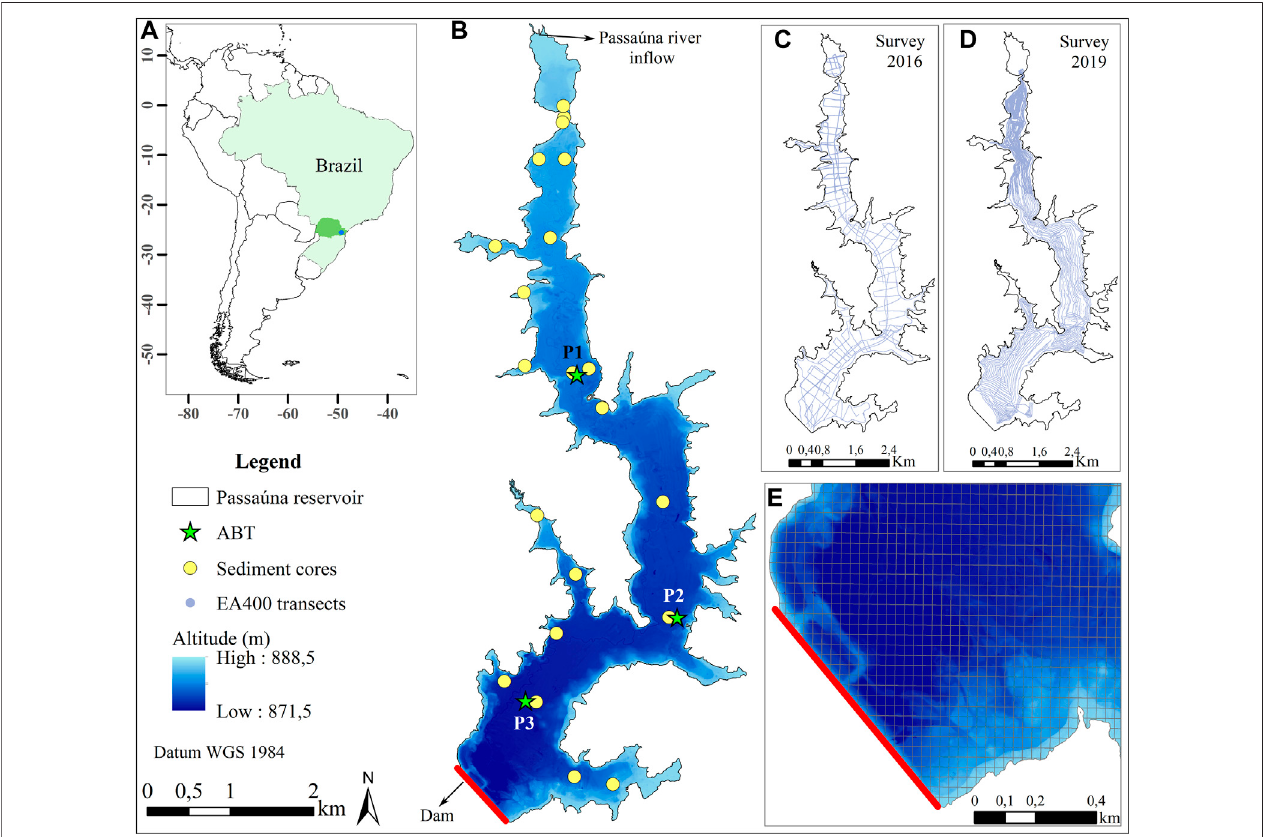
FIGURE 1 | (A) Location of the study site Passaúna Reservoir in South America; (B) Bathymetric map of Passaúna Reservoir and measurement locations (see legend); (C) echo-sounding transects during the survey in 2016; (D) echo-sounding transects during the 2019 survey; (E) Zoom to the dam area with overlaid analysis